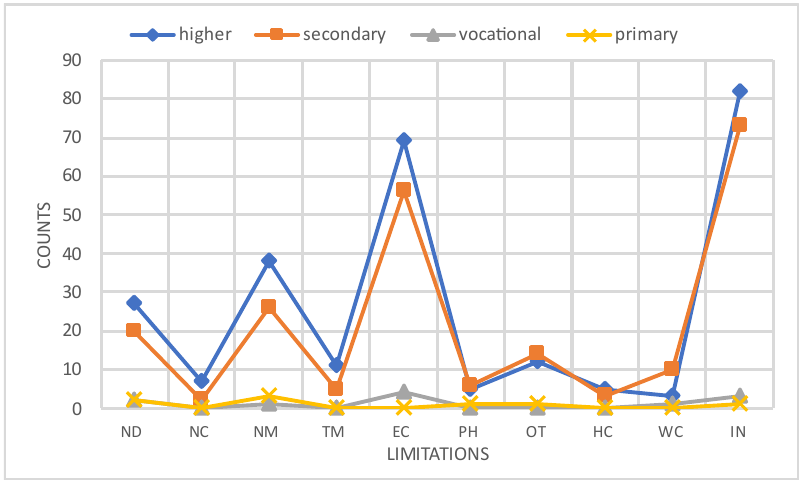
Figure 21. A graph of interactions between limitations in terms of car availability and the respondent’s education.